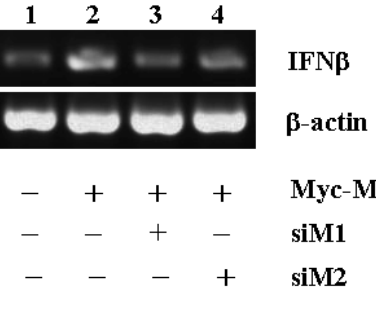
Figure 6. The counteractive effect of si-M1 and siM2 on M gene mediated interferon  production. HEK293 cells were co-transfected with 2  g plasmid pCMV-Myc-M plus 4  g of each pBS/U6 (lane 2), pBS/U6-siM1 (lane 3) or pBS/U6-siM2 (lane 4).